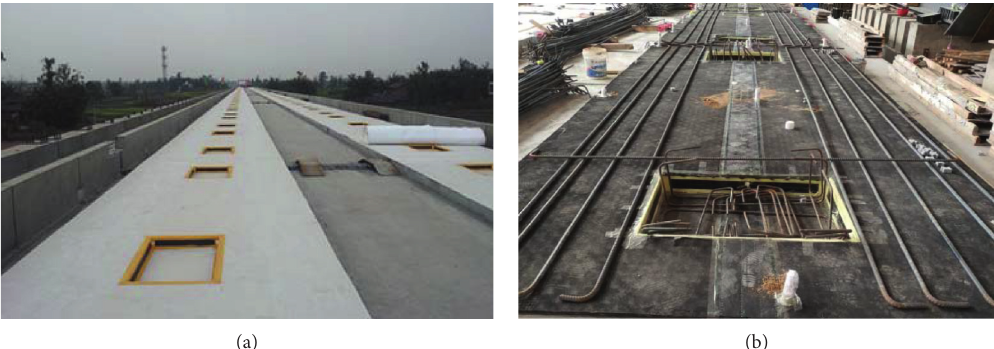
Figure 6: The unballasted tracks with different types of isolation layers: unballasted tracks with (a) geotextile isolation layer and (b) rubber isolation layer.